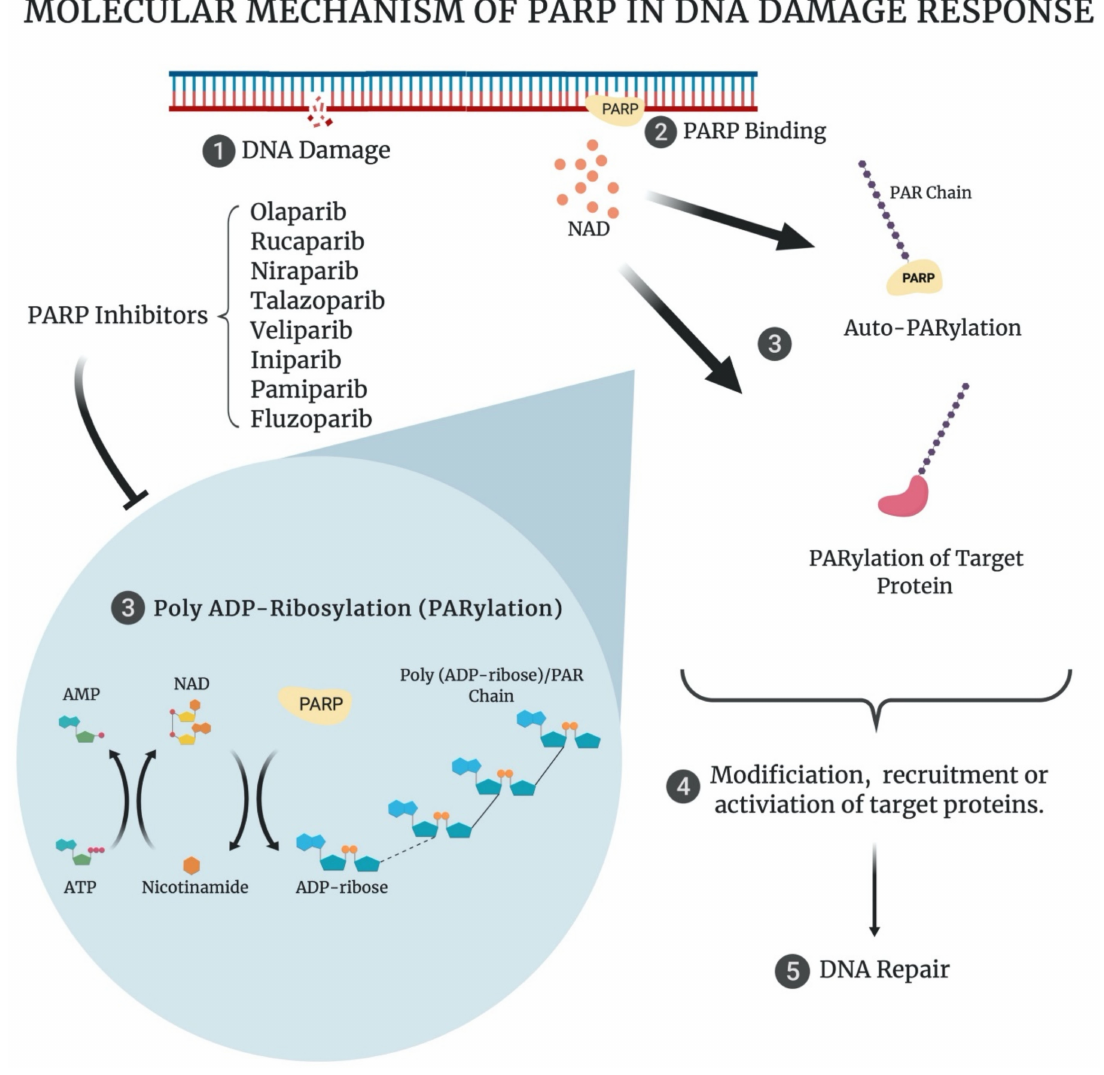
Figure 1. Molecular mechanism of PARP1/2 in the DNA damage response. ( 1 ). Nuclear DNA is damaged (SSB, DSB) ( 2 ). PARP1/2 binds to the DNA damage site, activating its enzymatic action. ( 3 ). PARP1/2 uses an NAD molecule to form an ADP-ribose molecule and a nicotinamide molecule. ADP-ribose is added to the target protein or to existing poly (ADP-ribose) chain. The target protein can be PARP1/2 (Auto-PARylation) or other DDR proteins (PARylation). PARP inhibitors disrupt NAD binding at this step. Nicotinamide is recycled to NAD in the presence of ATP. ( 4 ). Target DDR proteins are modified, recruited or activated as a result of PARylation. ( 5 ). Damaged DNA is repaired